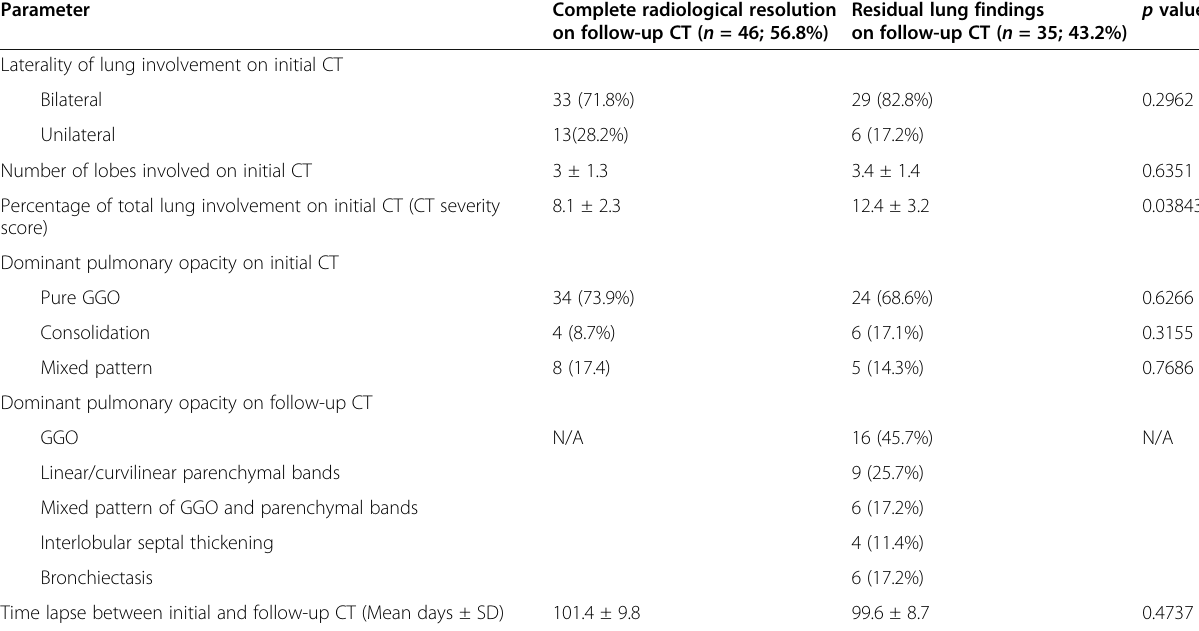
Table 2 Comparison of initial and follow-up CT between the two follow-up groups Parameter